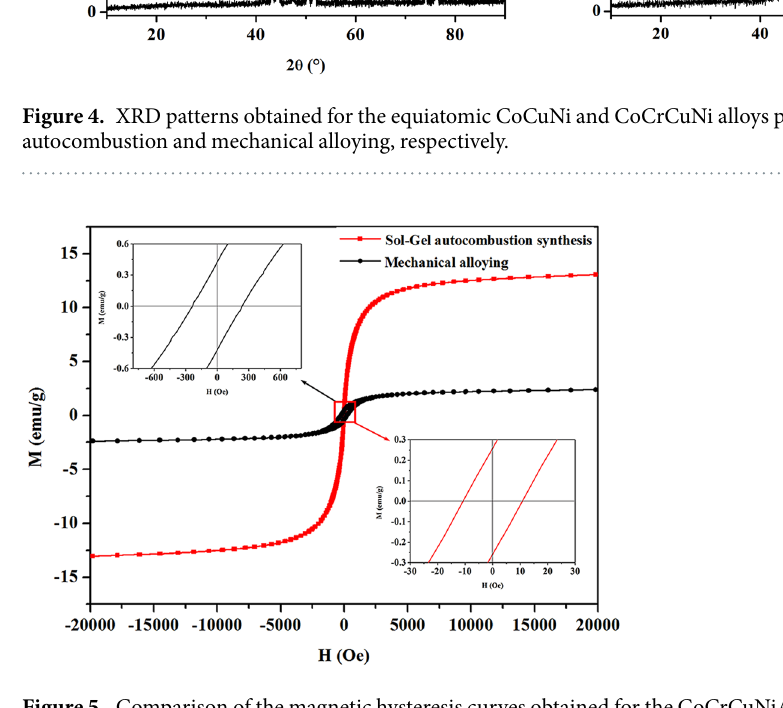
Figure 5. Comparison of the magnetic hysteresis curves obtained for the CoCrCuNiAl HEAs prepared via the sol–gel autocombustion and mechanical alloying,